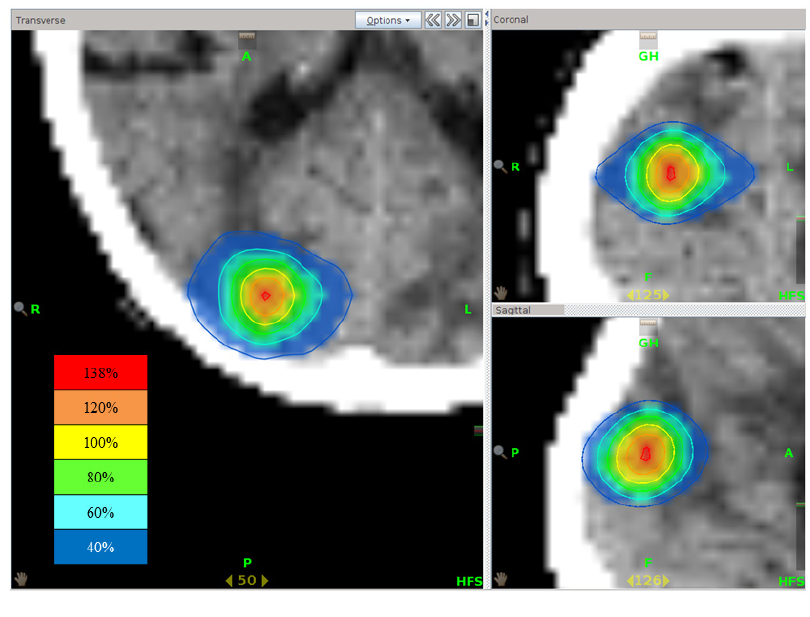
Figure 5. Isodose distribution of stereotactic radiotherapy using tomotherapy. The highest dose point is present at the central part of the brain